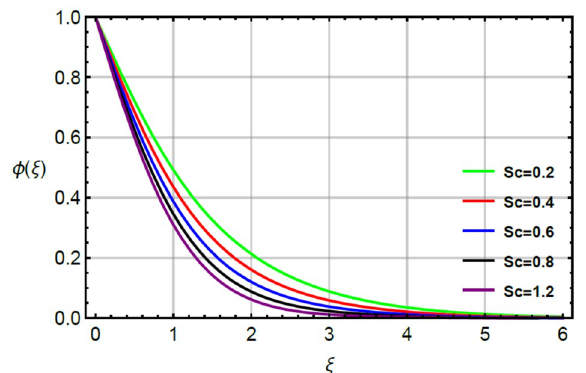
Figure 12. Character of Sc on φ .